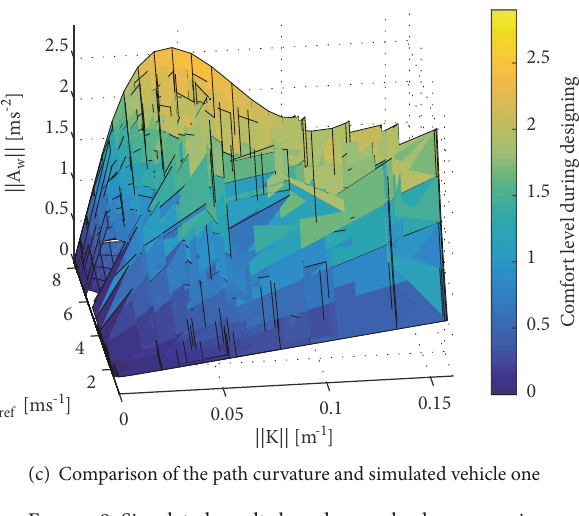
Figure 9: Simulated results based on real urban